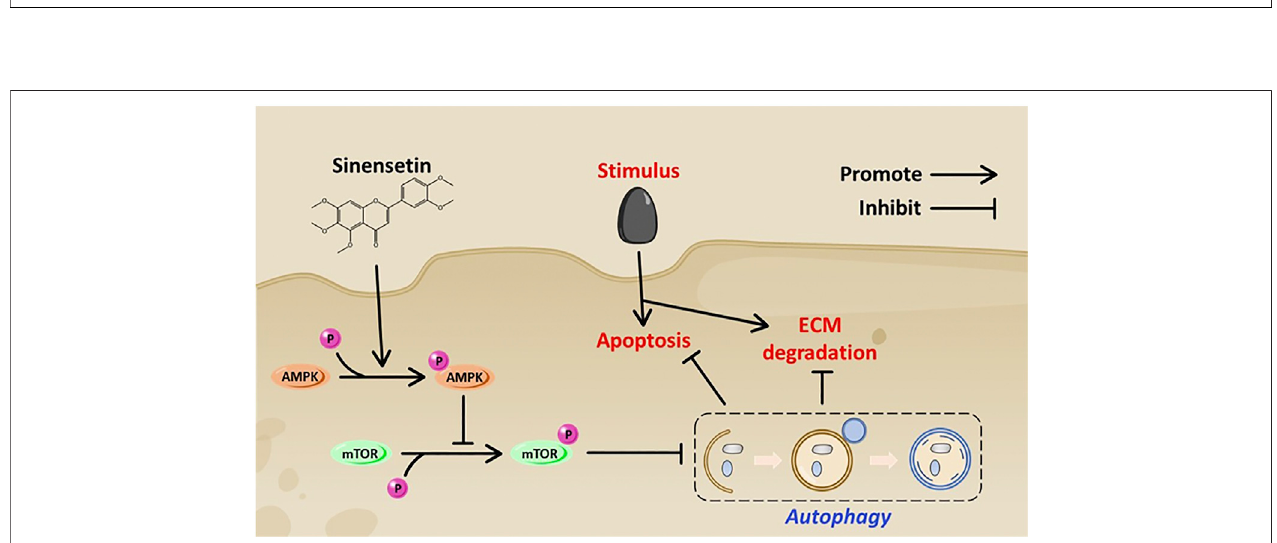
FIGURE 8 | Schematic diagram shows the potential protective effect of Sin on OA.